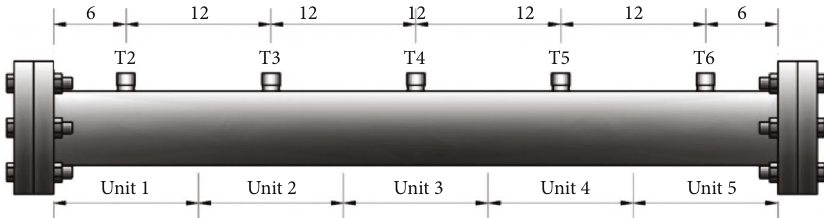
Figure 10: Schematic of the combustion tube for D block tests, with T1 to T5 being the temperature measurement points (12 cm